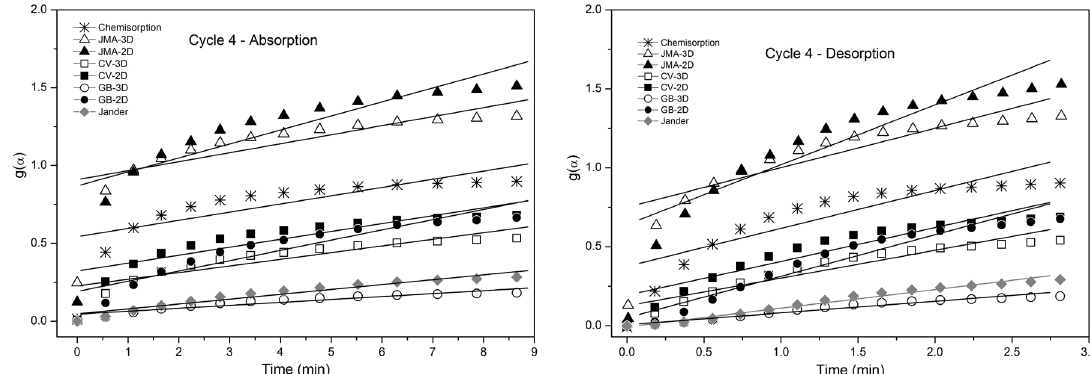
Figure 6. Linear fitting of the rate-limiting step models for the fourth hydrogenation and dehydrogenation of cold-rolled TiFe